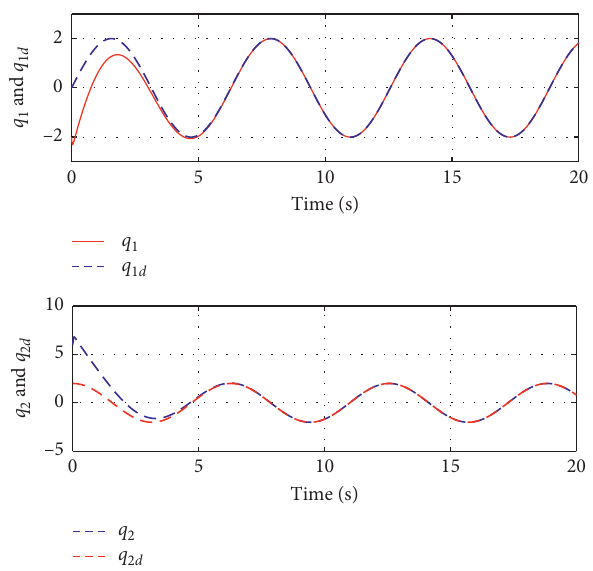
Figure 3: Position tracking of joint 1 and joint 2 of